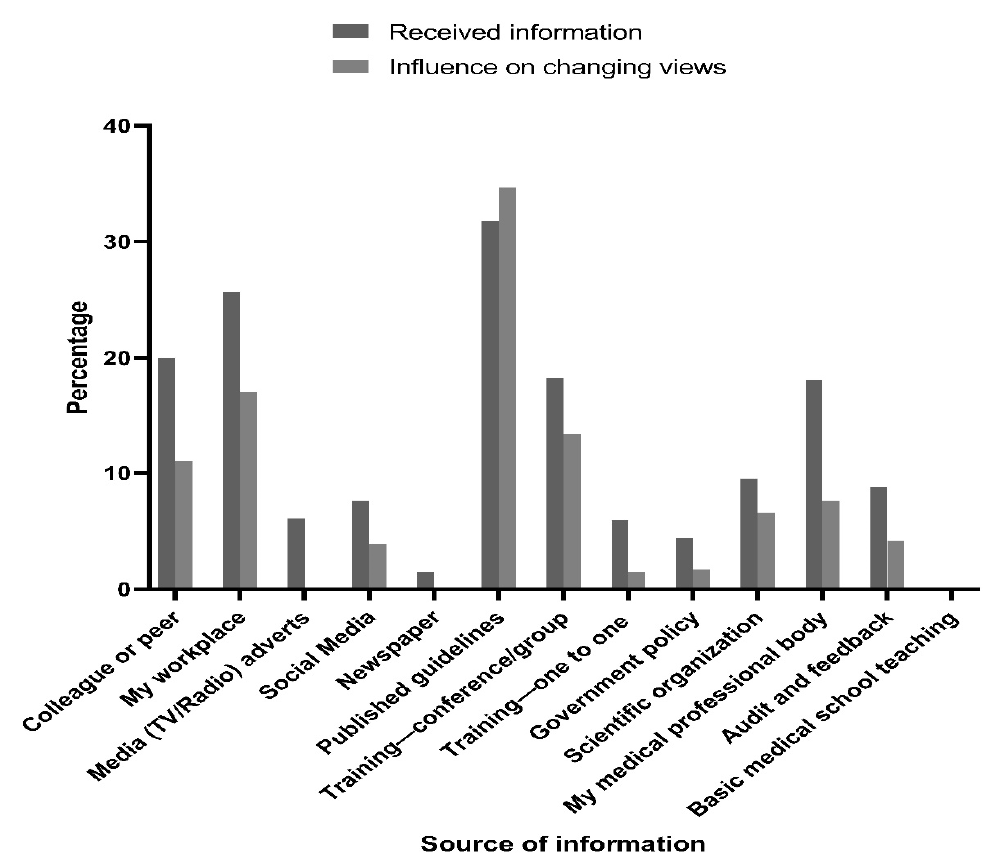
Figure 1. Sources of information about avoiding unnecessary prescribing antibiotics and their influence on changing physicians’ views ( n = 409).